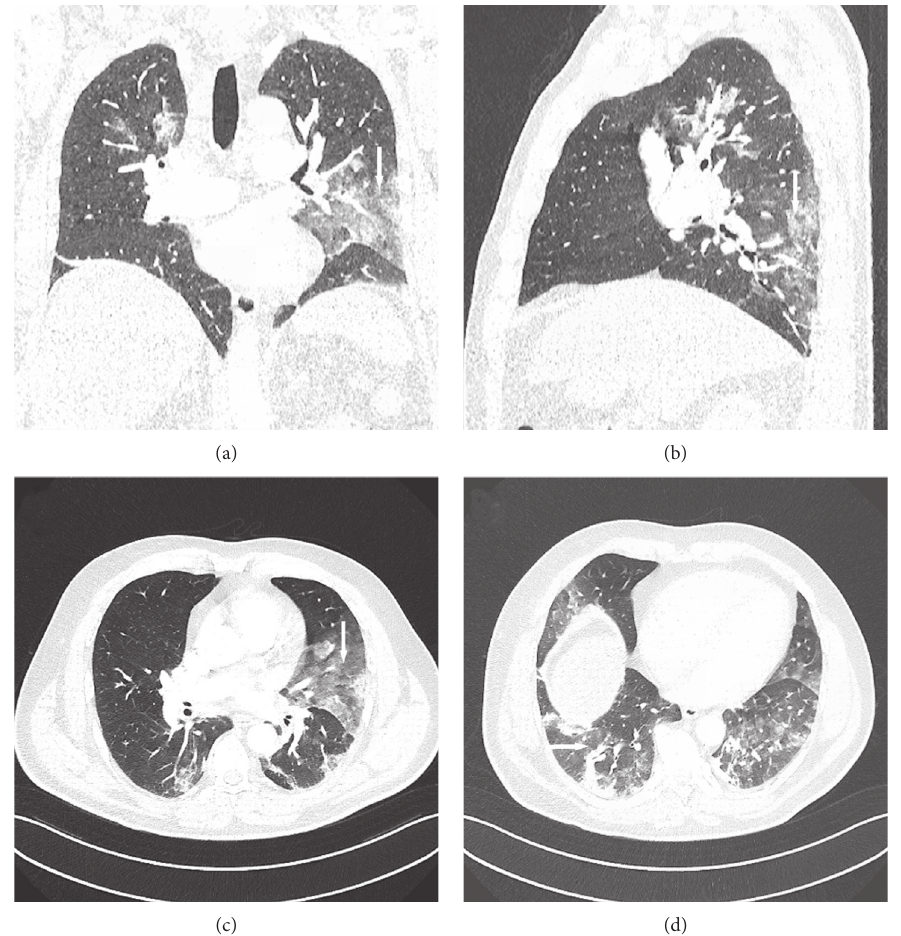
Figure 1: Chest computed tomography: (a) reconstruction in the coronal plane—“ground glass” opacities in both lungs; (b) reconstruction in the sagittal plane—“ground glass” opacities in the lower left lobe; (c) axial plane—“ground glass” opacities with a predominance of the left side; (d) axial plane—“ground glass” opacities and small areas of